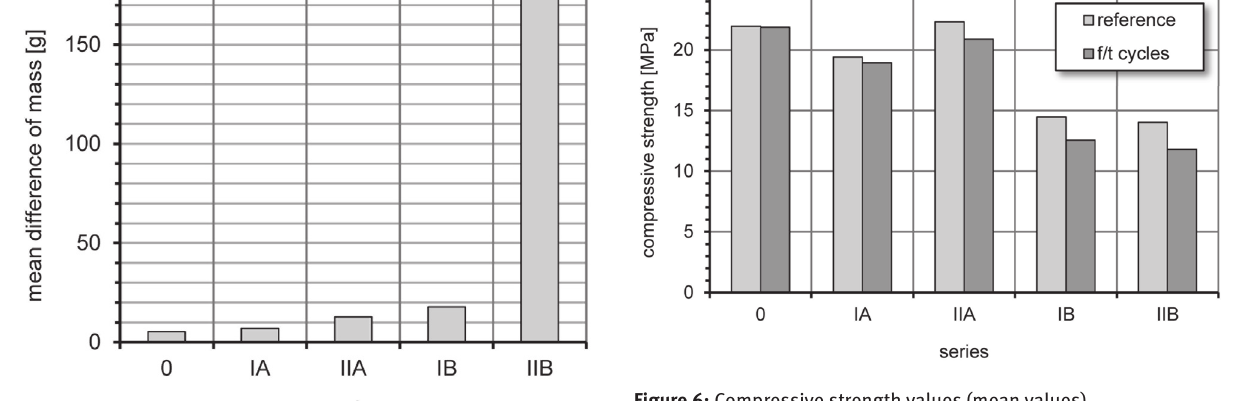
Figure 6: Compressive strength values (mean values).